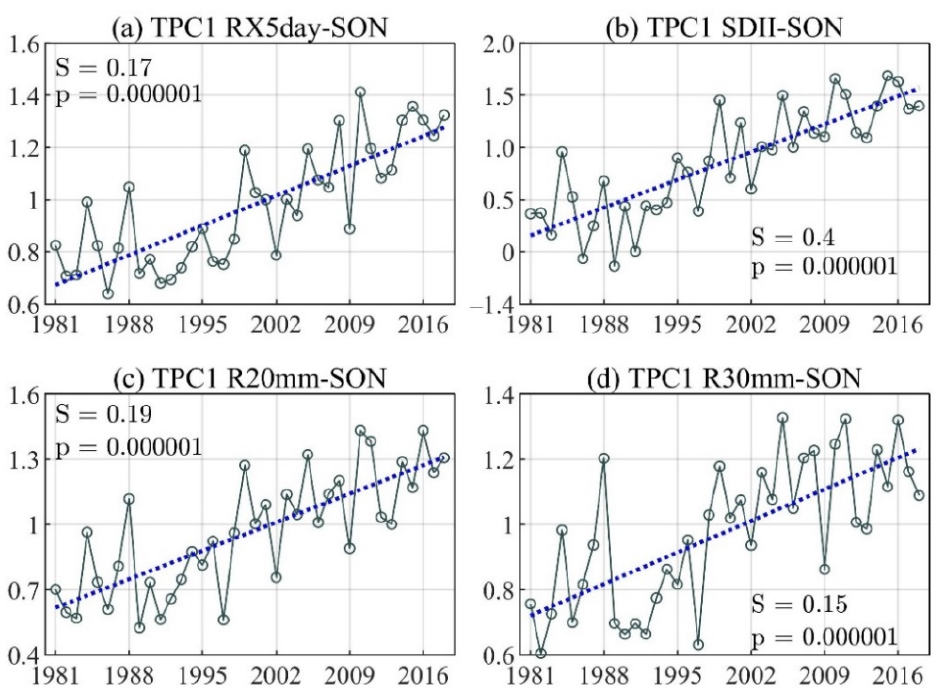
Figure 7. The linear trend of the principal component time series for the first TEOF mode of ( a ) Max 5-day precipitation amount (RX5day), ( b ) Simple daily intensity index (SDII), (c) Number of days with precipitations above R20mm (R20mm), and ( d ) Number of days with precipitations above R30mm (R30mm) during the July–August (JJA) season.